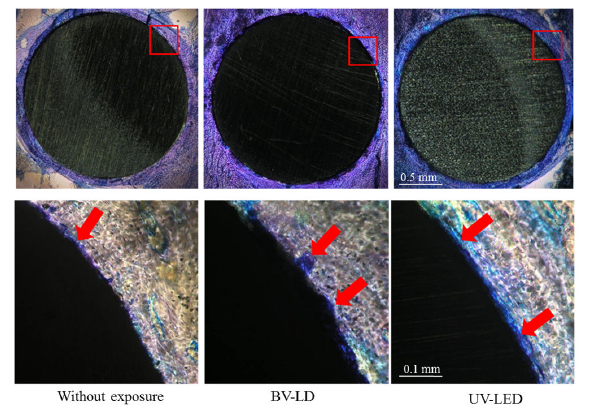
Figure 10. New bone formation area around the specimen 1 month after implantation of titania-treated specimens. doi: